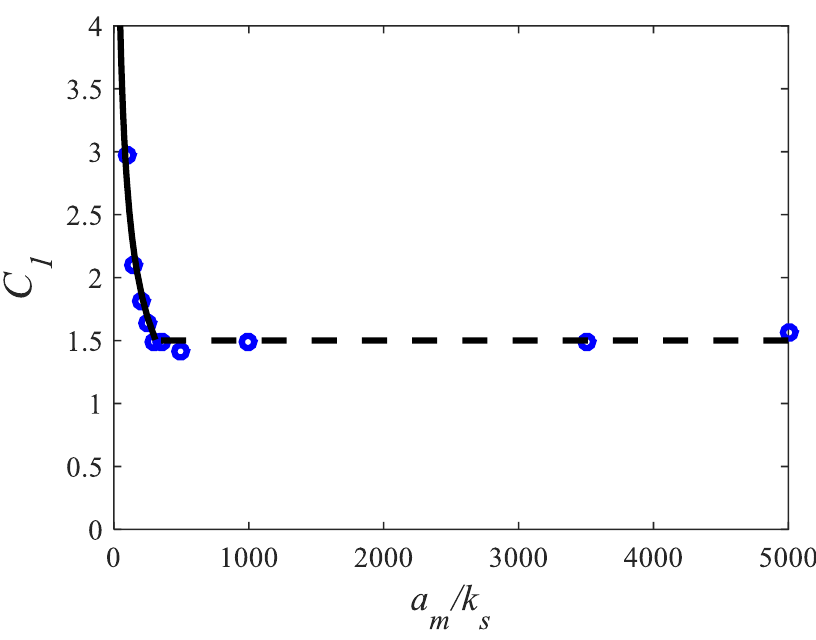
Figure 8. Parameter C 1 as a function of a m / k s , solid line: Equation (11), dashed line: constant value equal to 1.5, symbols: data from the BSL k- ω model.